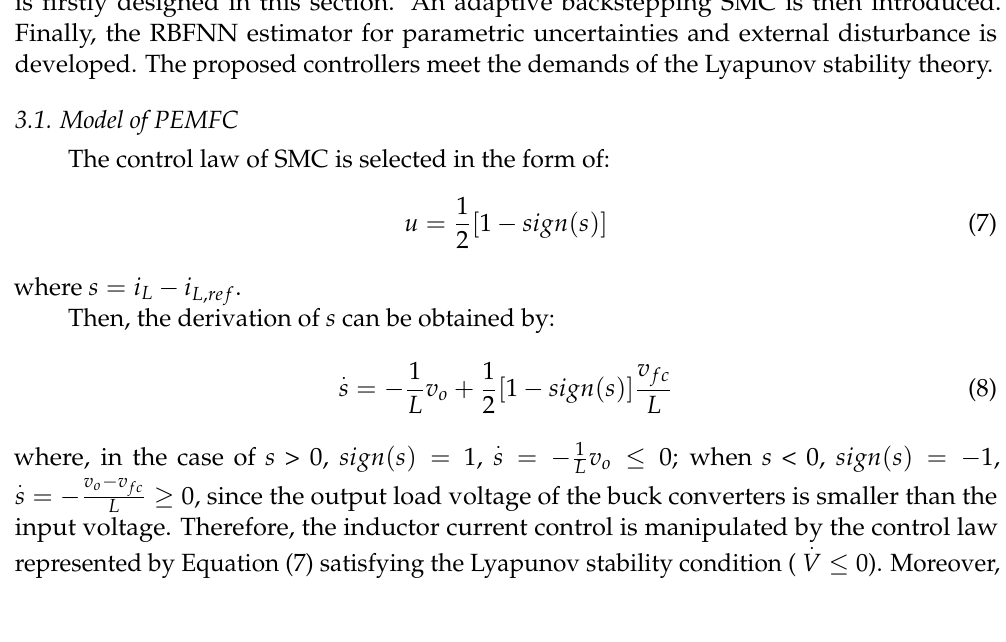
Table 1. The parameters of DC/DC buck converter and PEMFC system. Parameters Value Unit PEMFC power ( P fc ) 100 W Number of cells ( N ) 20 - Thickness of the membrane ( l fc ) 0.0178 cm Area of the membrane ( A fc ) 22.5 cm 2 Inductor ( L 0 ) 470 mH Capacitor ( C 0 ) 1000 µ F Constant resistance ( R 0 ) 2.05 × 10 − 2